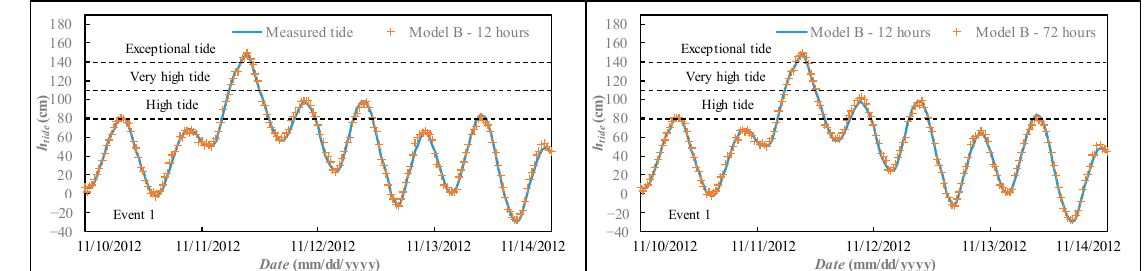
Figure 6. Event 1, extreme storm tide event forecasting for the period 10–14 November 2012, comparison between measured time series and predicted values: Model B, t a = 12 h (on the left ), t a = 72 h (on the right ). Table 3. Forecasting performance—Events: 1, 2 and